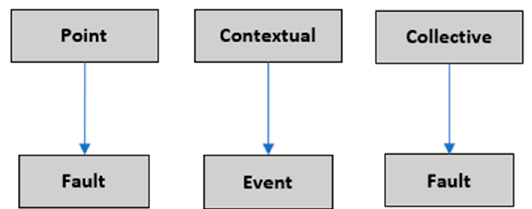
Figure 3. Fault/outlier model.